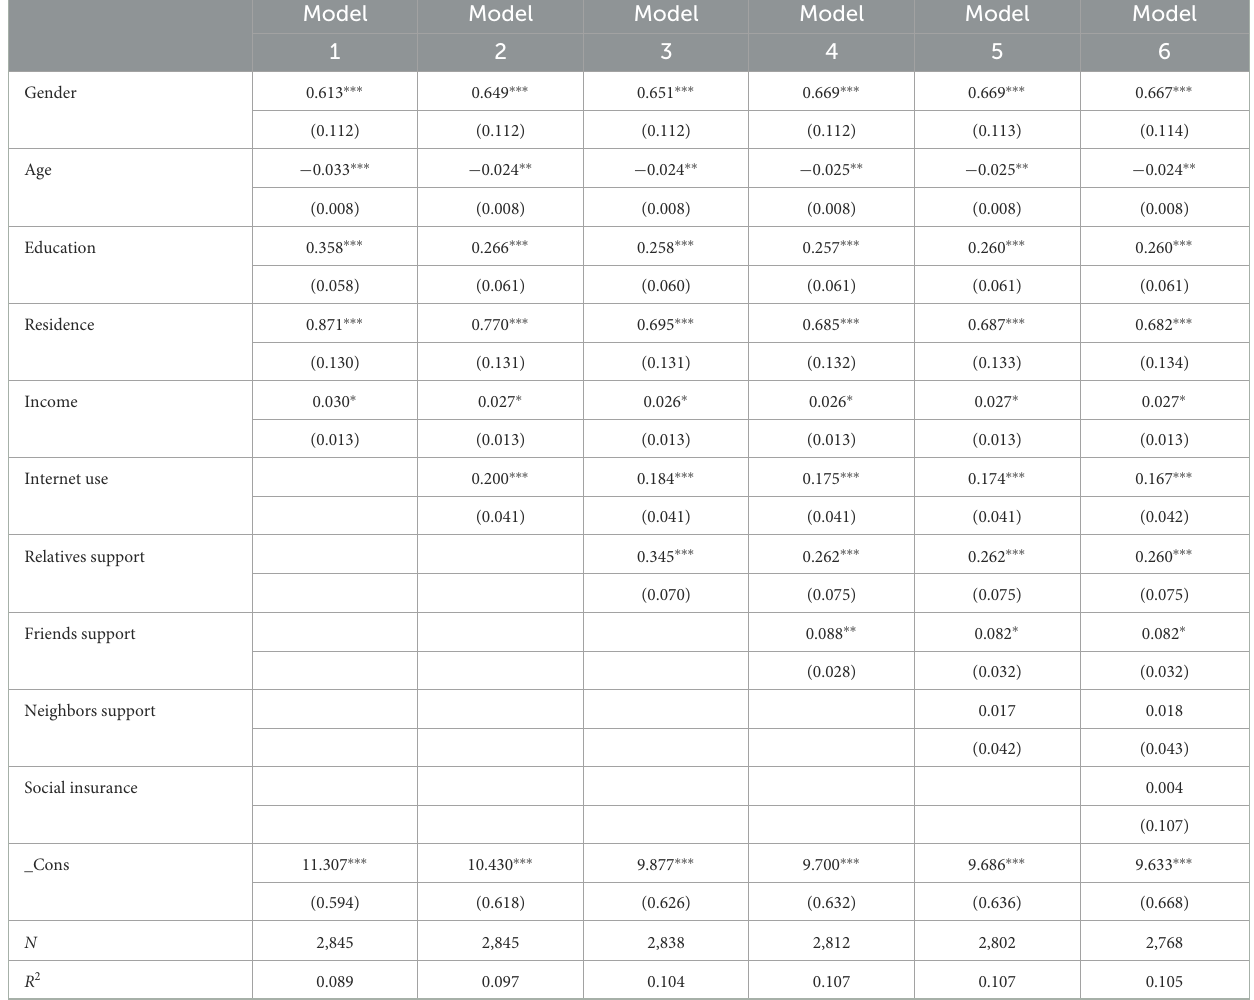
TABLE 4 Impacts of Internet use on Chinese older adults’ health status: based on OLS